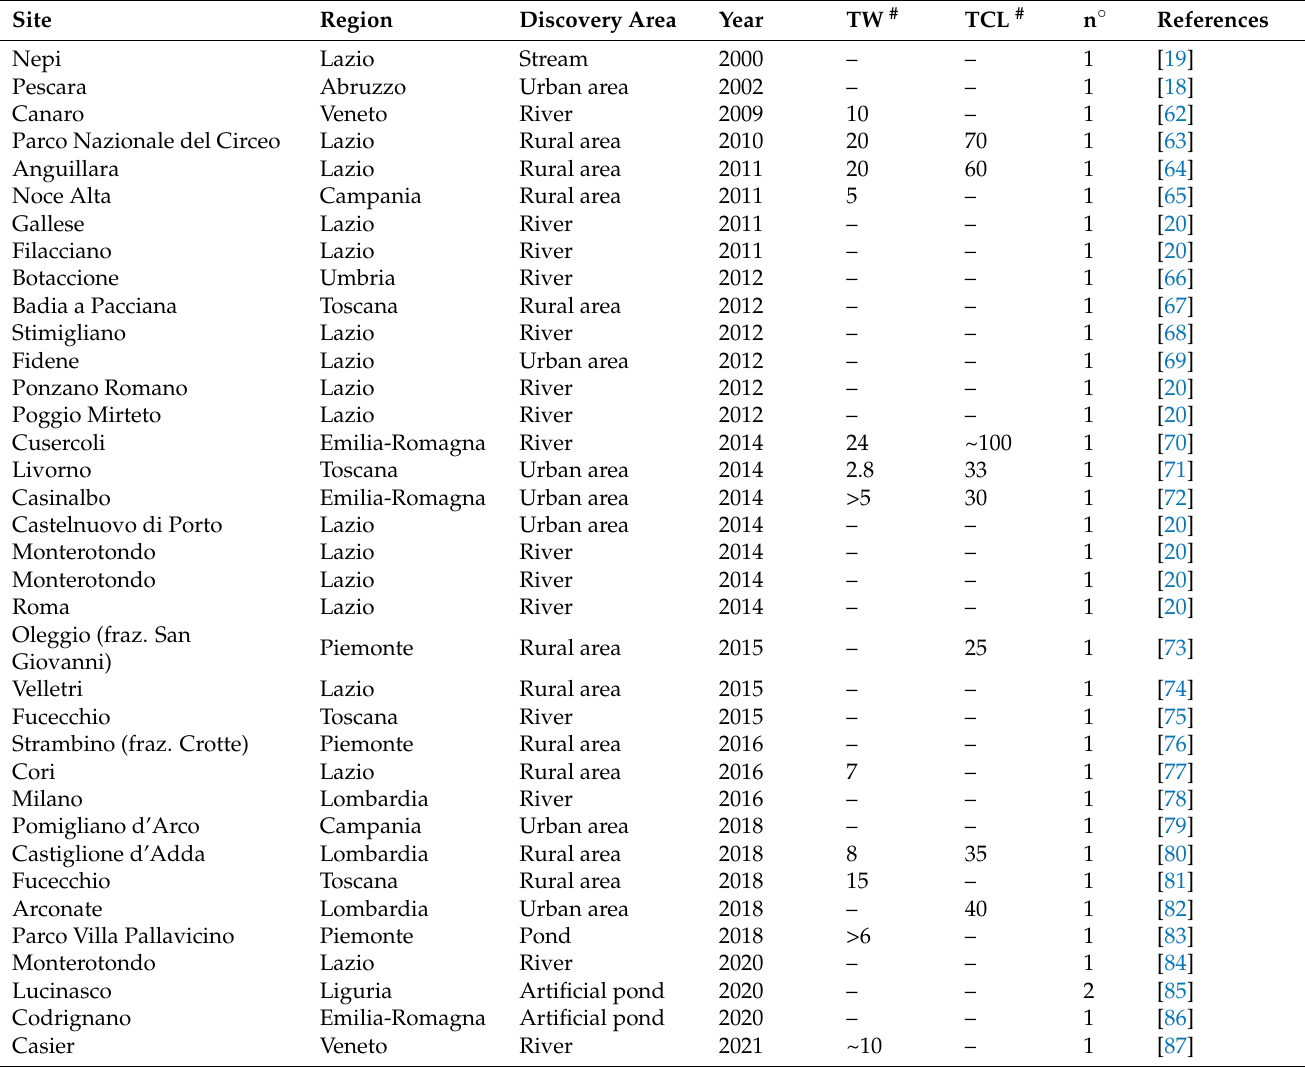
Table 2. Snapping turtle ( Chelydra serpentina ) reported in aquatic environments in